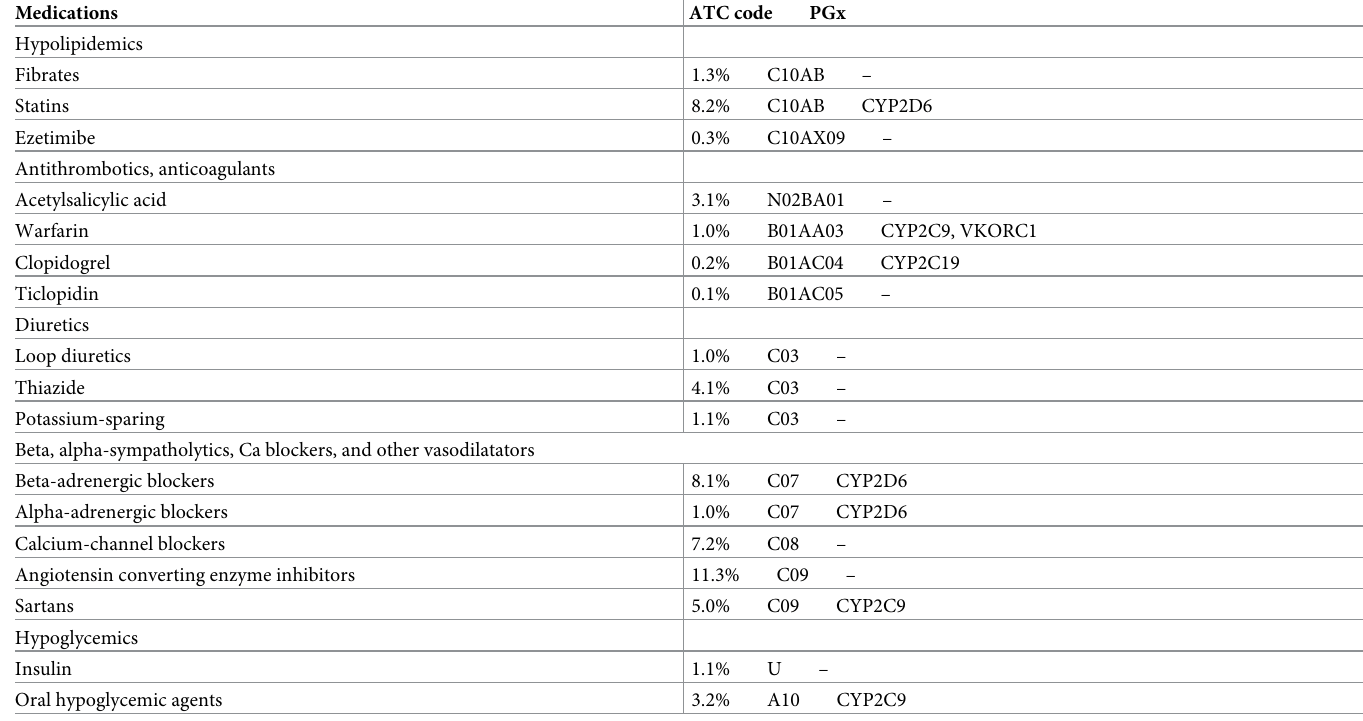
Table 1. Medication frequency in the overall Kardiovize study (n =